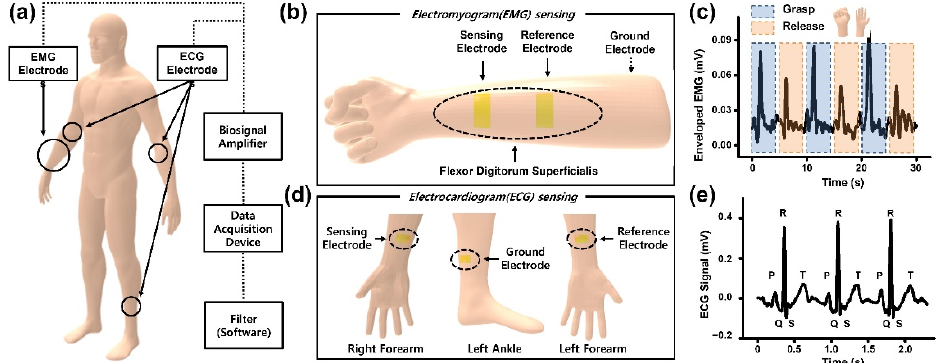
Figure 6. ( a ) Electrophysiology measurement setup. ( b ) Electrode positioning for EMG measurements. ( c ) EMG signals acquired from the forearm skin when the volunteer performed two hand gestures (grasping and releasing). ( d ) Electrode positioning for the ECG measurements. ( e ) ECG signals acquired from the volunteer’s body. Several alphabetic captions expressed the cardiac signal state (PQRST peaks).